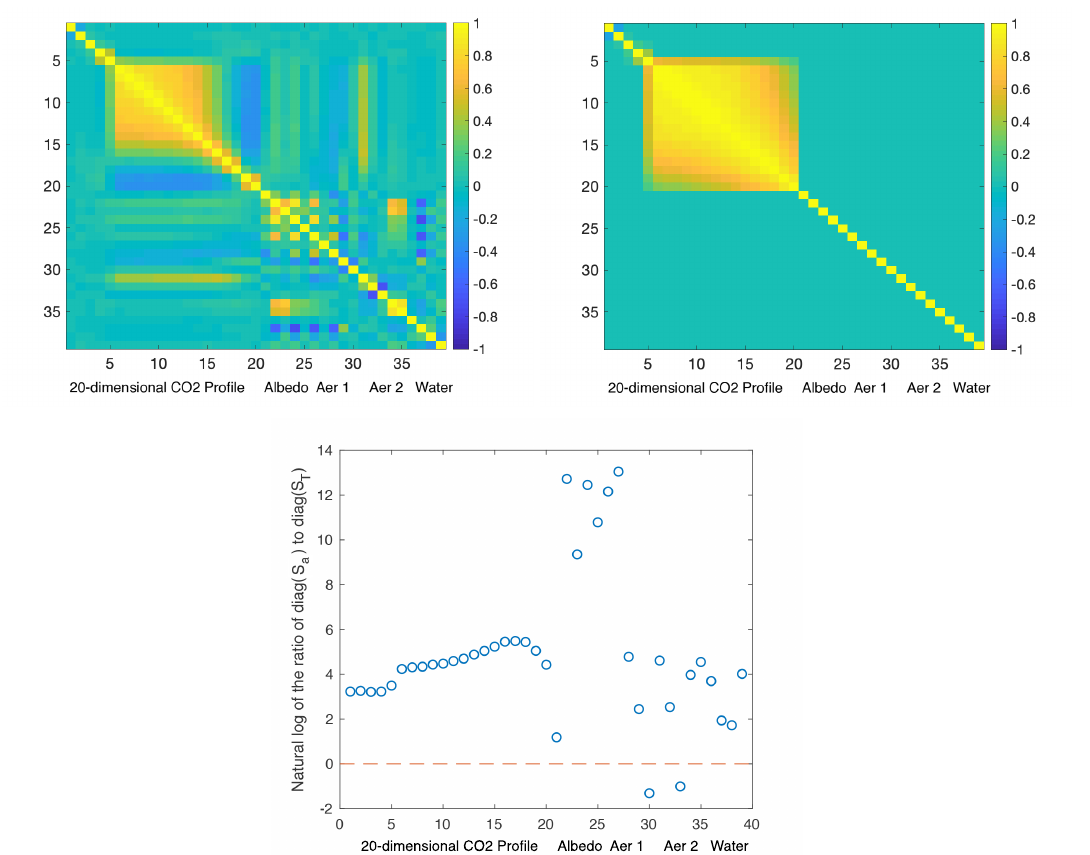
Figure 1. Top row: Plots of the true prior correlation matrix (computed from S T , left panel) and the working prior correlation matrix (computed from S a , right panel) used in the Observing System Simulation Experiment (OSSE) simulation. Note that the top plots are in correlation space because the original covariance matrices have vastly different magnitudes. Bottom row: Natural log of the element-wise ratio of the diagonals of S a to the diagonals of S T . The red dashed line indicates the dividing line at which the working prior variance is equal to the true prior variance. The figure is reproduced with permission from